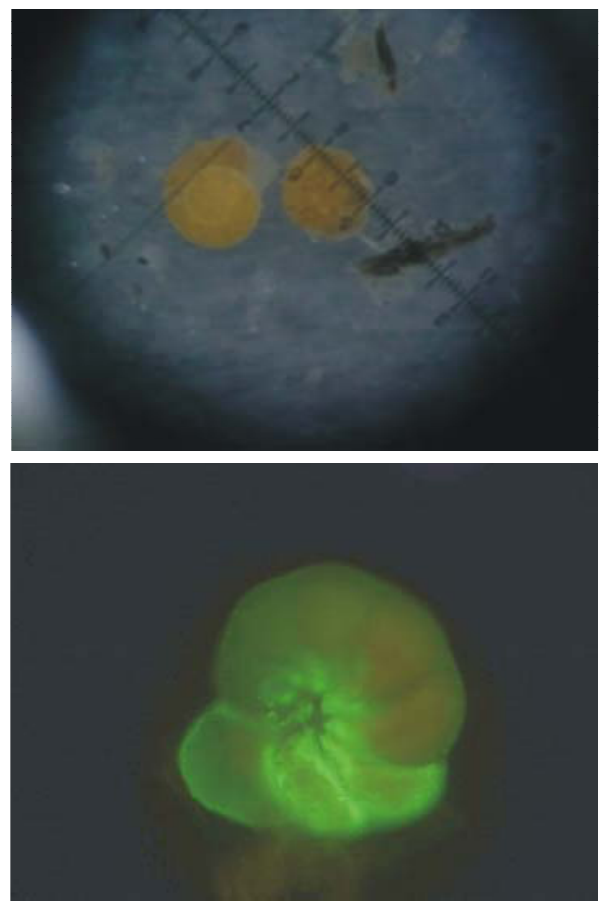
Fig. 1. Ammonia tepida under the light microscope (top), Ammonia tepida under UV light showing newly grown chambers marked with calcein (bottom).